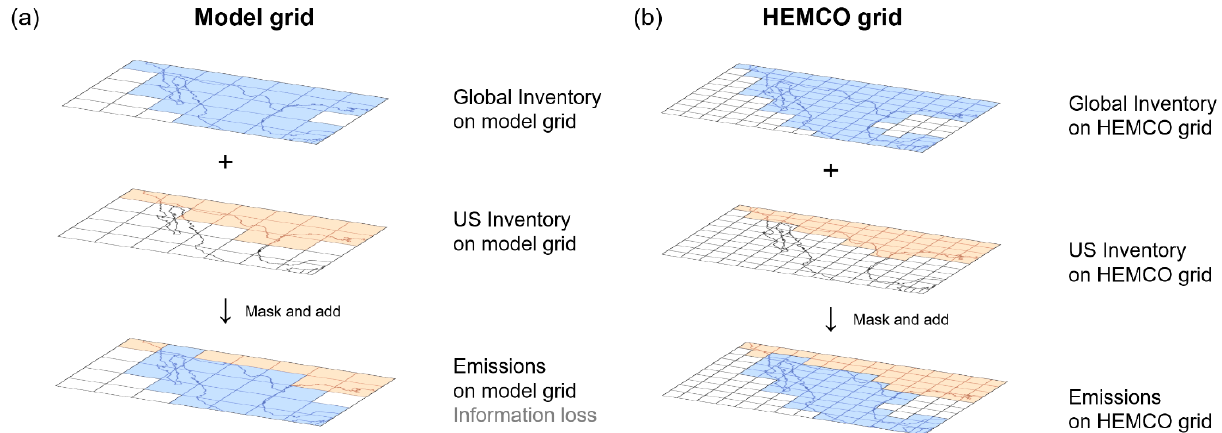
Figure 3. Benefit of using a HEMCO grid finer than the model grid for masking of emissions by a regional inventory. The example in the figure illustrates a case in which a US inventory (orange) is used to replace a global default inventory (blue) in a model simulation on a coarse 4 ◦ × 5 ◦ grid. The mask is by necessity binary so that US inventory emissions are applied only to grid cells that are 100% in the US. Using the finer (2 ◦ × 2.5 ◦ ) HEMCO grid allows for better resolution of the US–Mexico border and hence for more of the US inventory to be used near the